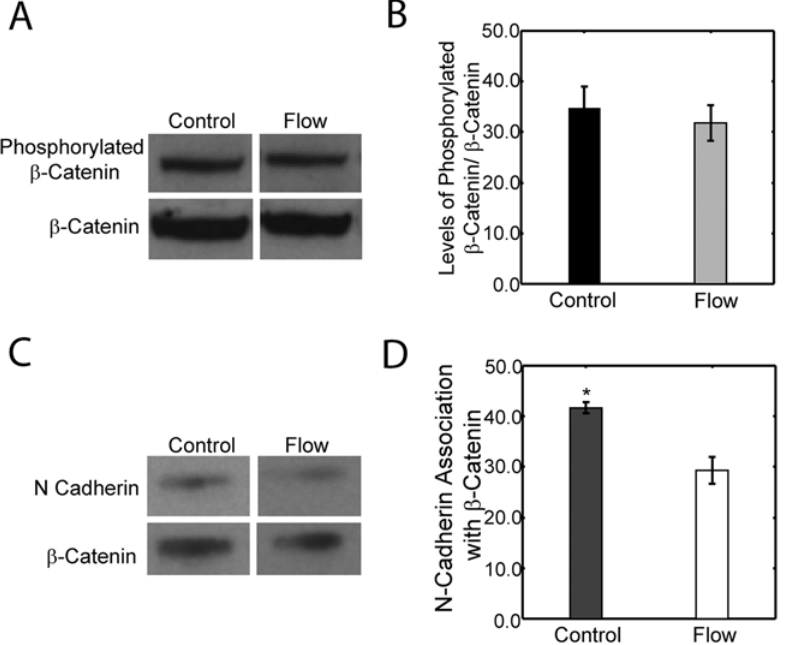
Figure 5. Flow-induced b -catenin signaling may be mediated by cadherin signaling rather than canonical Wnt signaling. (A) Western blots were used to determine the level of phosphorylated b -catenin in cells exposed to oscillatory fluid flow versus controls. (B) Analysis of the western blot indicates that there is no significant difference between control and experimental cells in the level of phosphorylated b -catenin. (C) A western blot was also used to assay N-cadherin association with b -catenin as a function of mechanical stimulation. (D) Analysis of the western blot demonstrates that there is a significant 30% decrease in b -catenin/N-cadherin association with exposure to 35 minutes of oscillatory fluid flow (p , 0.01). (Error bars: SEM (n $ 4)).